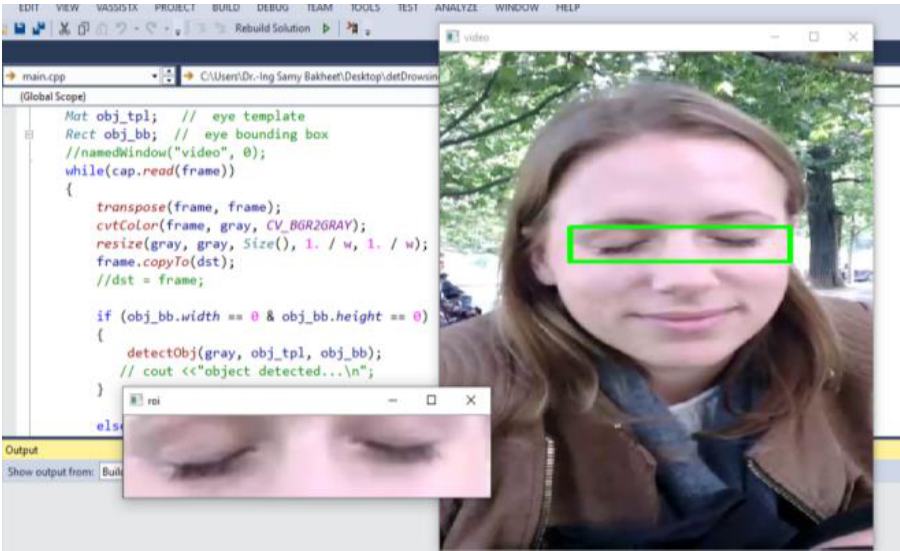
Figure 4. A sample snapshot of the resultant eye-pair region localization in our framework for driver drowsiness